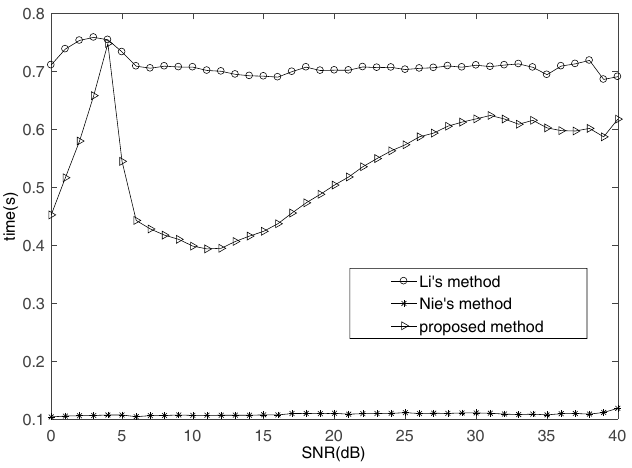
Figure 5. CPU time comparison of different methods.